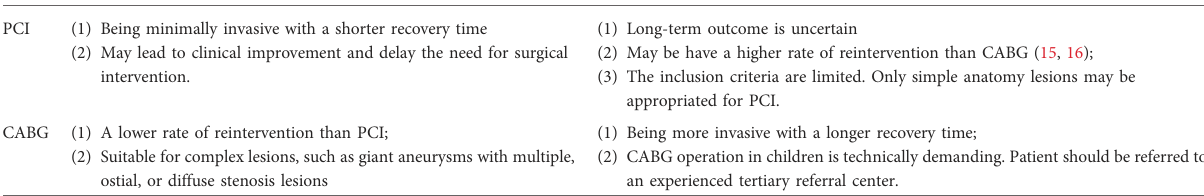
TABLE 2 PCI vs. CABG in CA lesions with KD.